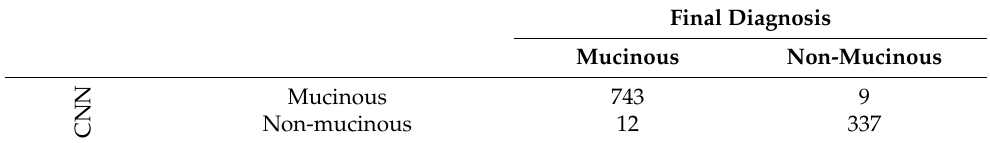
Table 2. Confusion matrix of the automatic detection versus final diagnosis.